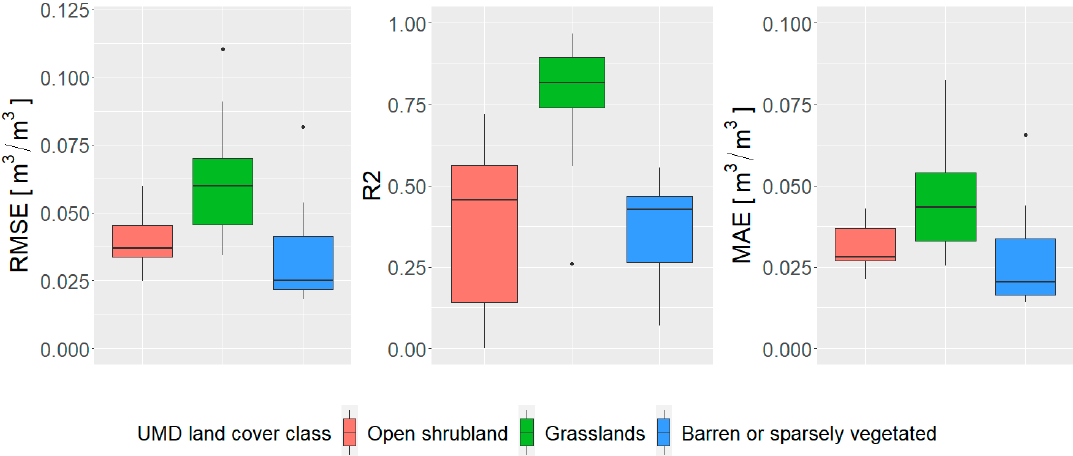
Figure 11. Boxplot of the calculated metrics (without NDVI shift) per stations differentiated by MODIS land cover classes (UMD classification scheme).